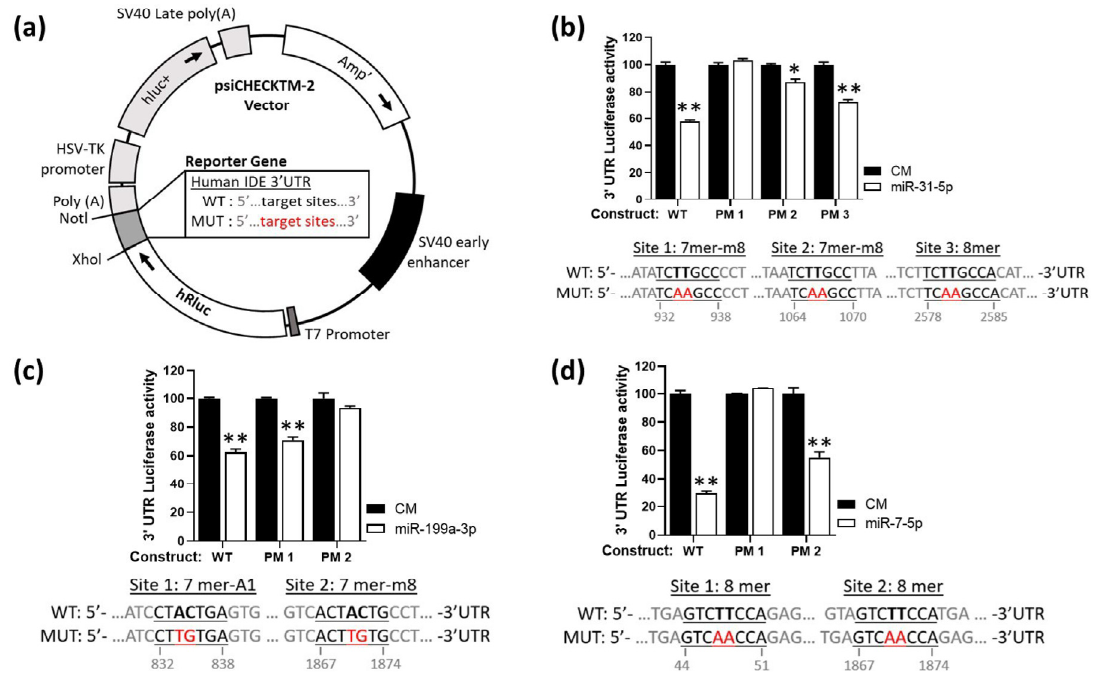
Figure 3. Human IDE 3 (cid:48) UTR sequence contains target sites for miR-31-5p, miR-199-3p and miR-7-5p. ( a ) psiCHECKTM-2 vector representation. ( b – d ) Underlined sequences indicate the miRNAs binding sites. Nucleotides highlighted in red indicate the point mutations in the miRNAs binding sites. Luciferase reporter activity in HEK-293 cells transfected with the CM or miRNAs mimic and the IDE 3 (cid:48) UTRs (wild-type (WT)) or the constructs containing the indicated point mutations (PM). Data are expressed as relative luciferase activities compared to the activity in control samples co-transfected with an equal concentration of the CM and correspond to the mean SEM from three experiments performed in triplicate. * p < 0.05, ** p < 0.01 (significantly different from cells co-transfected with CM and the WT or PM 3 (cid:48)